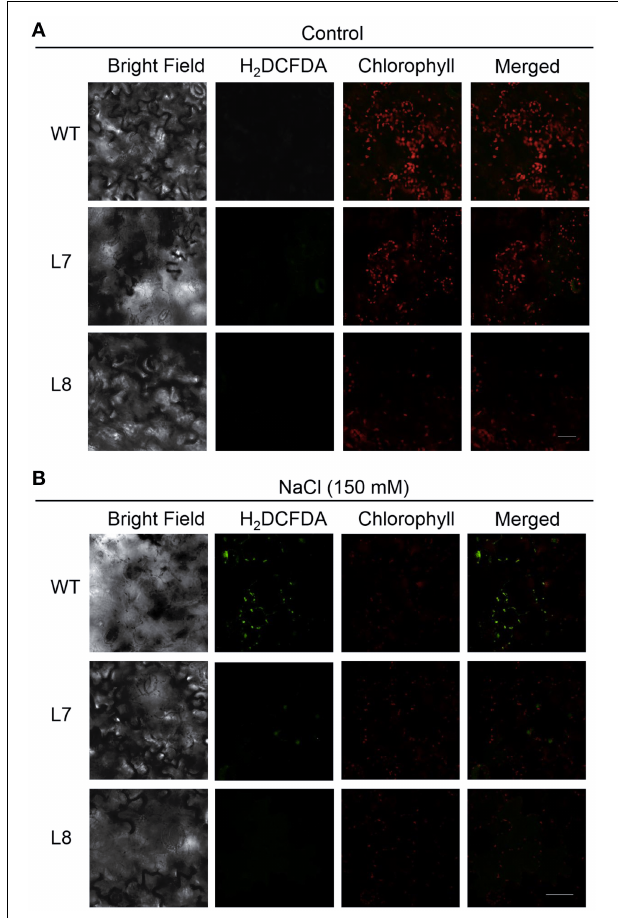
FIGURE 9 | Effect of NaCl on chloroplast H 2 O 2 production in wild-type tobacco and KcCSD -transgenic lines. Seeds of wild-type (WT) and transgenic lines (L7 and L8) were germinated on MS medium for 7 days, then supplemented with 0 (A) or 150mM NaCl (B) for 7 days. Seedlings treated with or without NaCl were stained with 10 μ M H 2 DCF-DA for H 2 O 2 detection. Green fluorescence of H 2 DCF-DA and red auto-fluorescence of chlorophyll were monitored separately using a confocal laser scanning microscope, and two color fluorescence images were merged. Bars = 20 μ m.